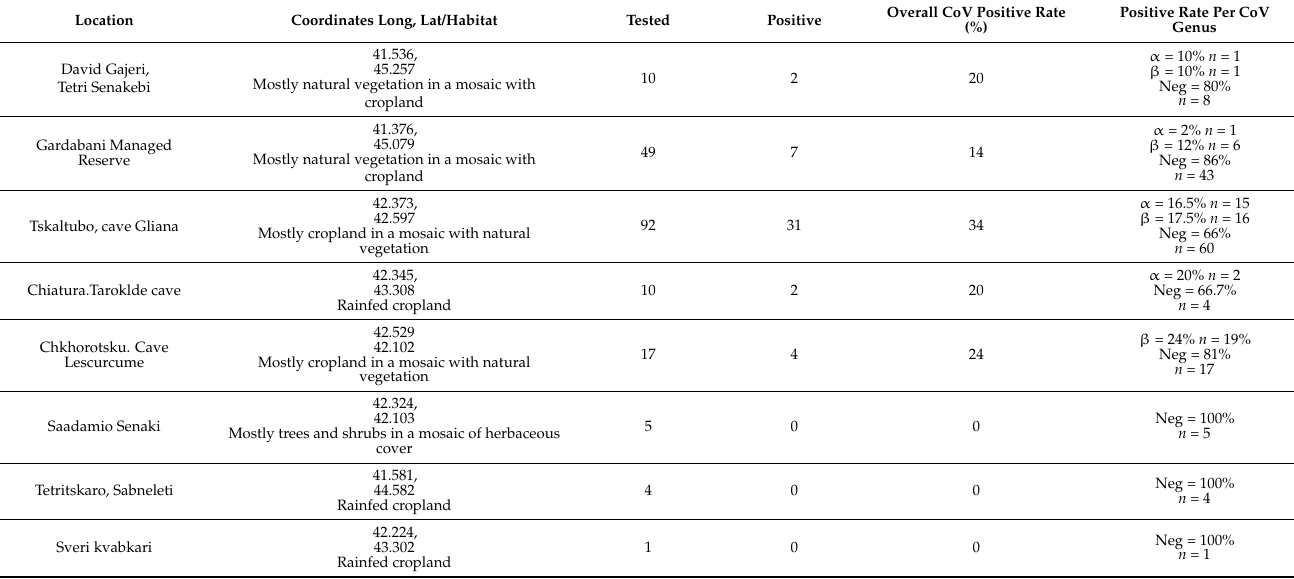
Table 1. Detailed location of collection sites and type of land use or cover. Overall and per genus coronavirus positive